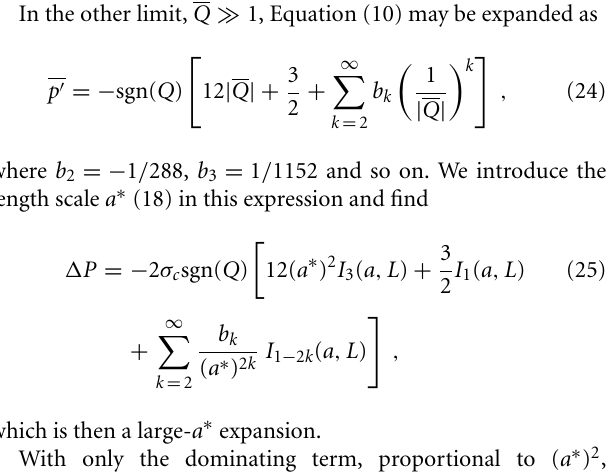
FIGURE 1 | Labels “1” and “2” refer to two positions along a one-dimensional channel. The pressure gradient thresholds are p (cid:7) c 1 and p (cid:7) c 2 respectively. The total flow rate through the channel is the same at all positions. Hence, when the total flow rate is Q a , there will be a corresponding pressure gradient p (cid:7) 1 a at position 1 and a pressure gradient p (cid:7) 2 b at position 2. When the total flow rate is lowered to Q b , the pressure gradients become p (cid:7) 1 b and p (cid:7) 2 b at positions 1 and 2 respectively. From the figure, we see that as Q → 0, the pressure gradients p (cid:7) 1 and p (cid:7) 2 reach their respective thresholds, p (cid:7) c 1 and p (cid:7) c 2 ,